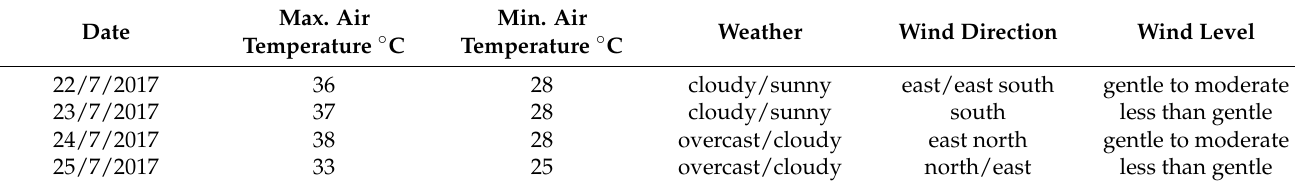
Figure 4. Instruments’ installations of the reference point ( A ) and for mobile measurements ( B ). Table 3. Meteorological data of the measurement days.